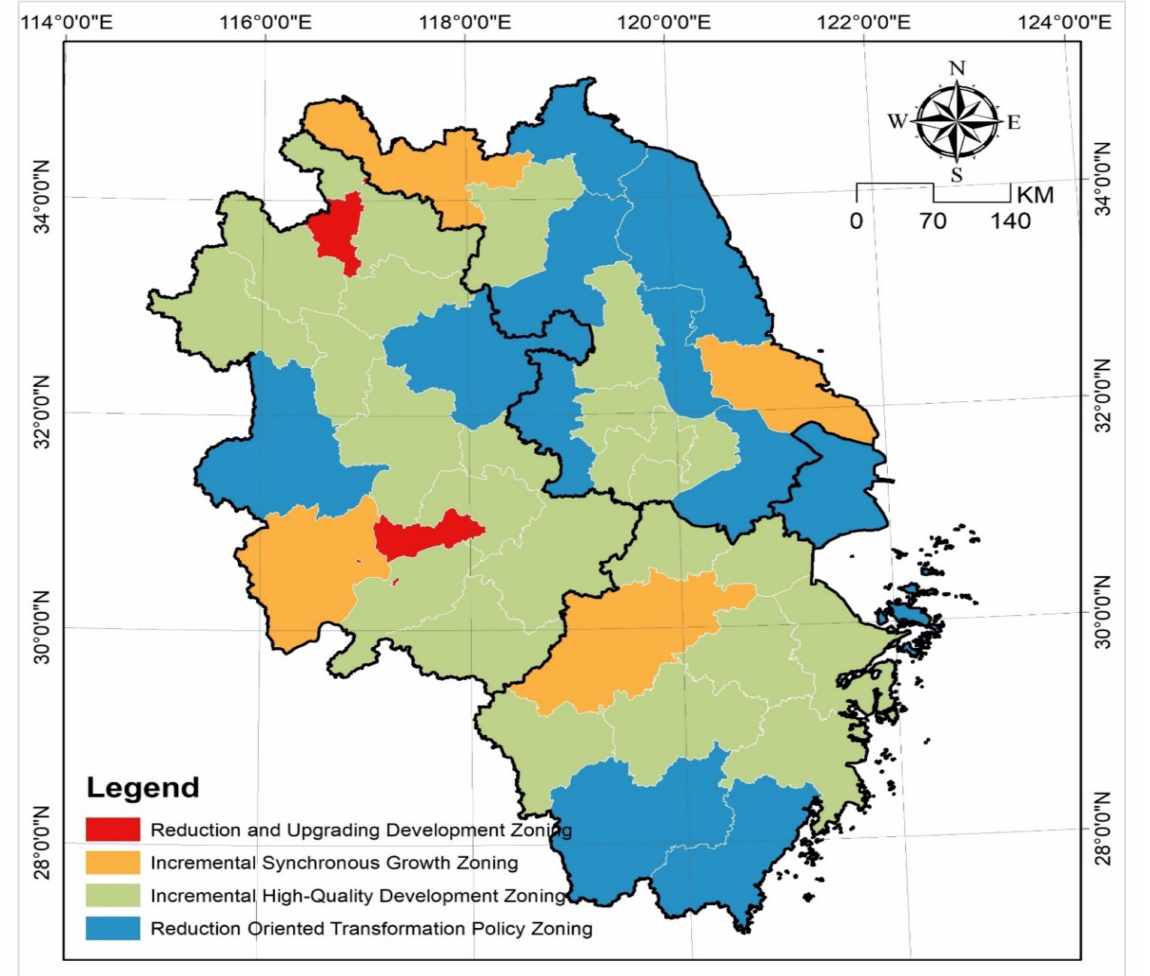
Figure 12. Analysis on the zoning management in Yangtze River